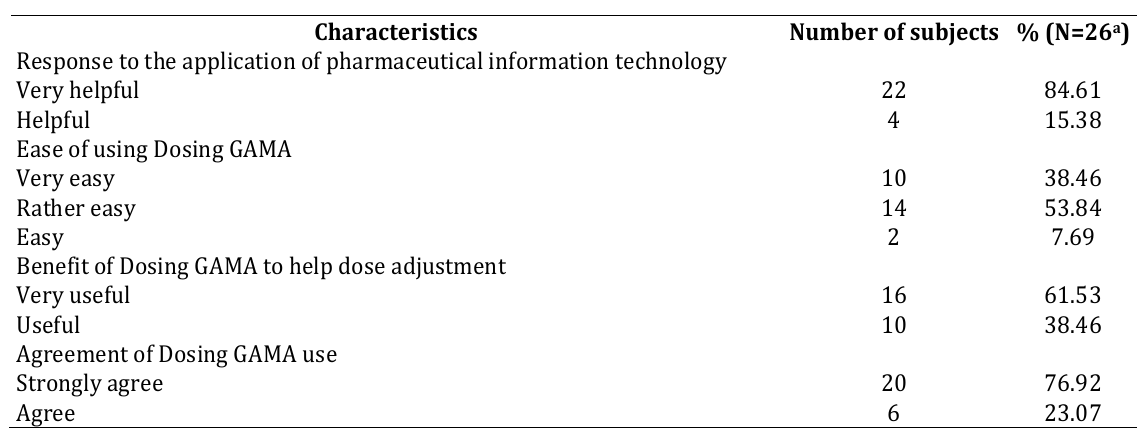
Table V. Pharmacist acceptance response to the application